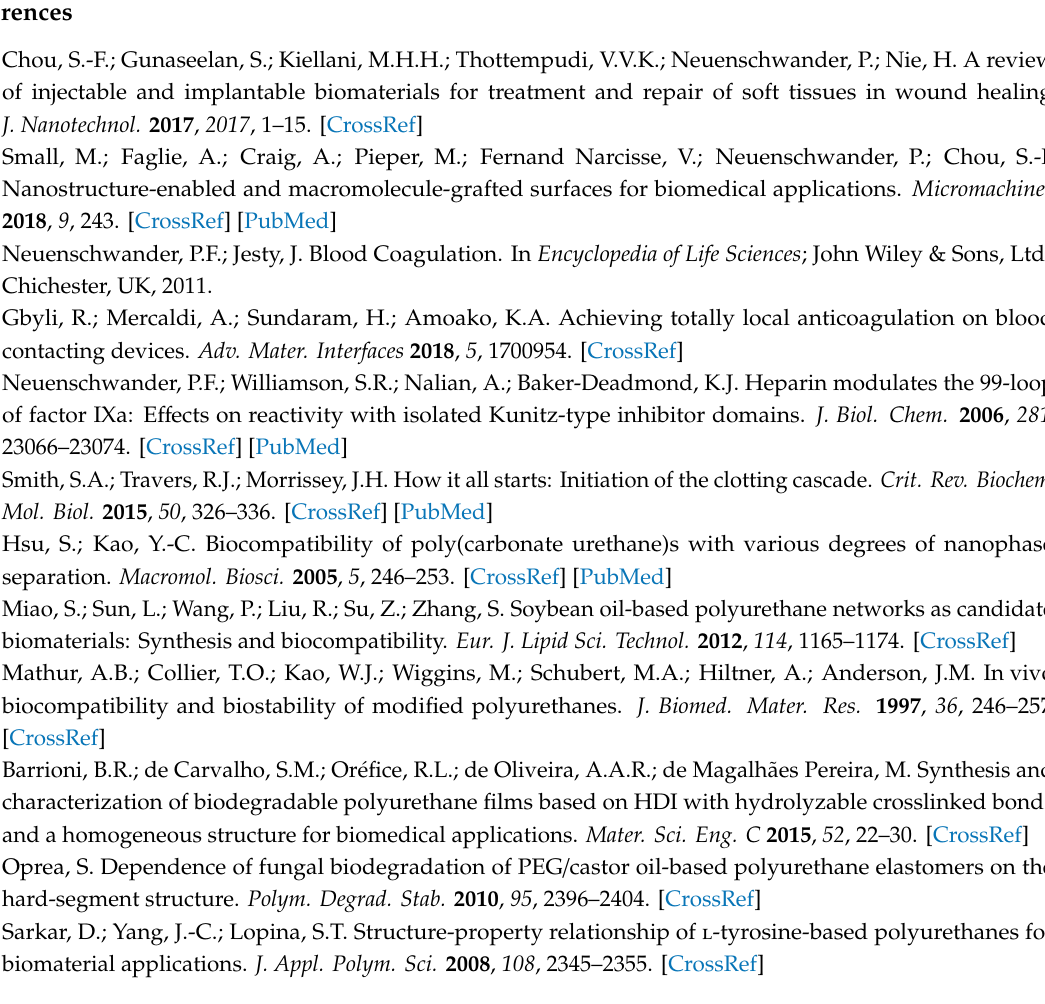
Figure S1: NMR spectrum of 60ES sample, Figure S2: NMR spectrum of 100ES sample, Figure S3: NMR spectrum of 60ET sample, Figure S4: NMR spectrum of 200ET